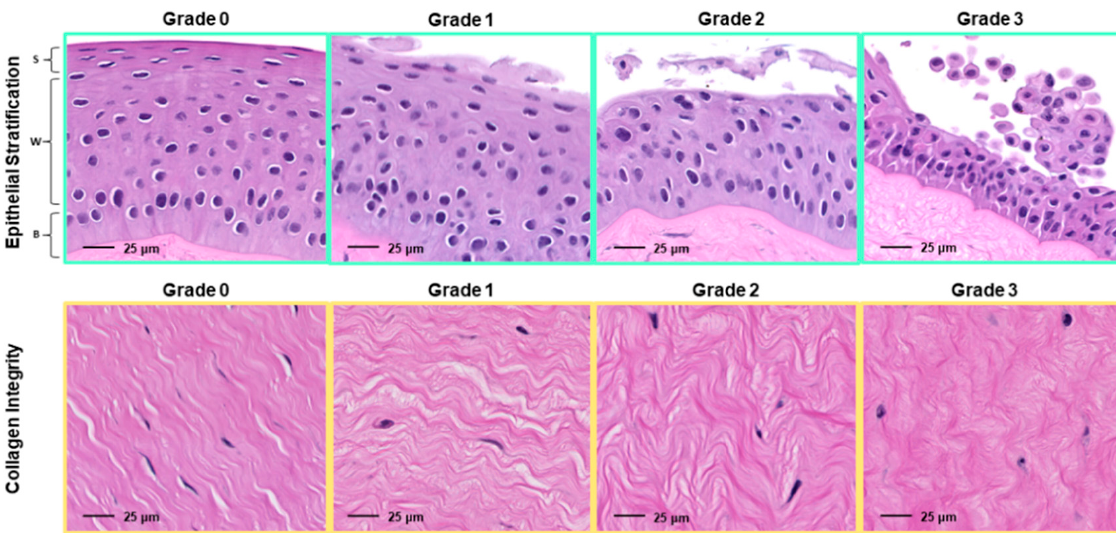
Figure 2. Semiquantitative histopathology grading scheme for bovine corneal sections. Epithelial stratification:0 = clear distinction of basal, wing, and squamous cell layers; 1 = weak disorganization with minor squamous separation; 2 = moderate disorganization with moderate squamous separation; 3 = marked disorganization with significant squamous separation and degenerate basal cell attachments. Basal (B), wing (W), and squamous (S) cell layers are indicated in the Grade 0 image. Stromal organization: 0 = no stromal disorganization; 1 = weak stromal disorganization; 2 = moderate stromal disorganization; 3 = marked stromal disorganization. All images are photomicrographs magnified to 400X.